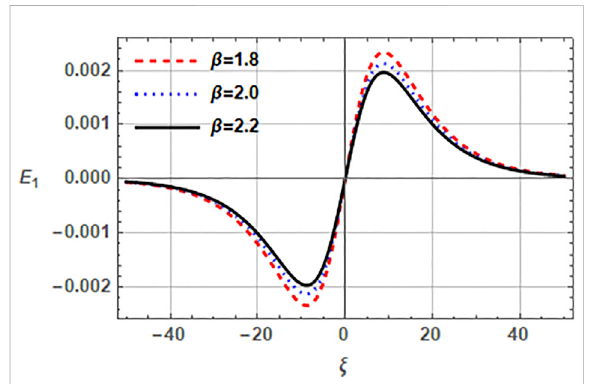
FIGURE 6 Normalized electric fi eld E 1 ( ξ , τ ) of EASWs is plotted versus the ratio of temperatures σ c (= T c / T h ). Here q = 2.5, r = 0.4, n h 0 =